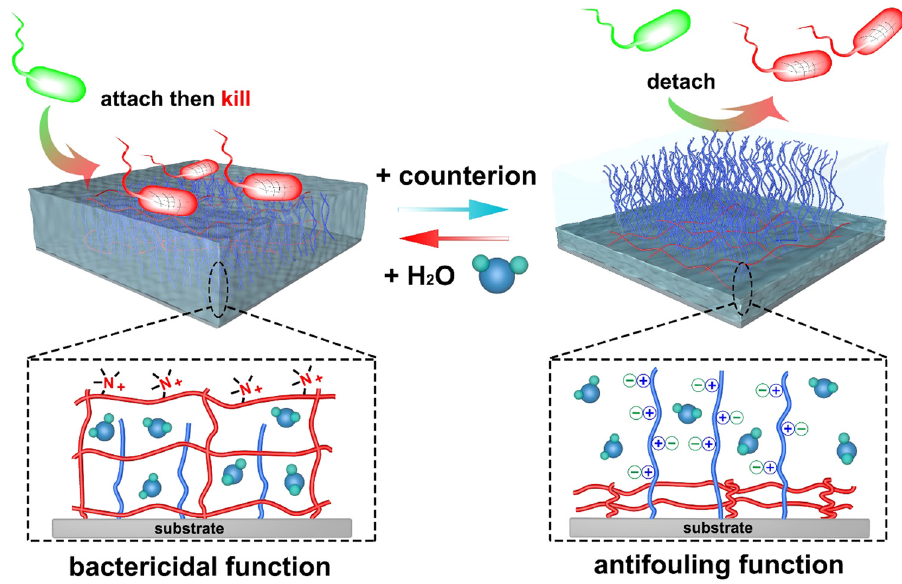
Figure 5: Schematic illustration of the switchable contact killing – releasing property of PSBMA - P ( HEAA - co - METAC ) in water and salt